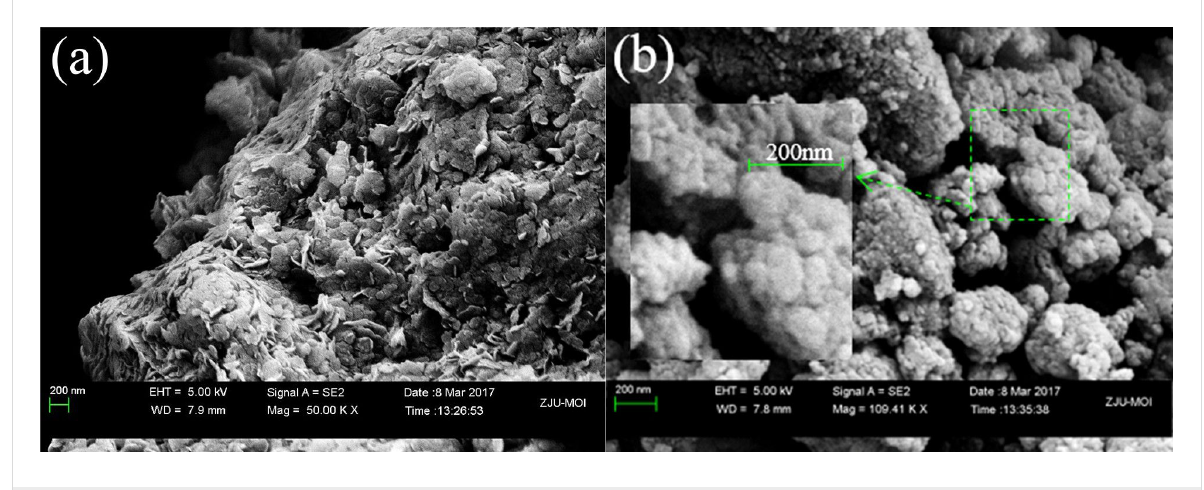
Figure 9: SEM images of (a) NLDH and (b)